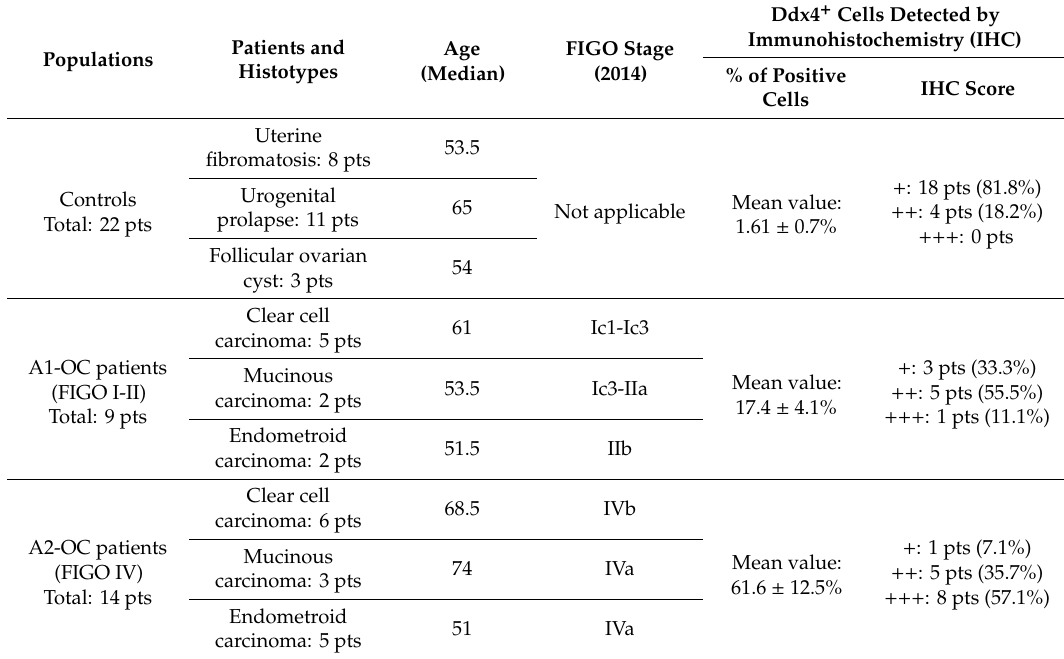
Table 1. Groups of patients, histotypes and mean values of intraovarian Ddx4 +